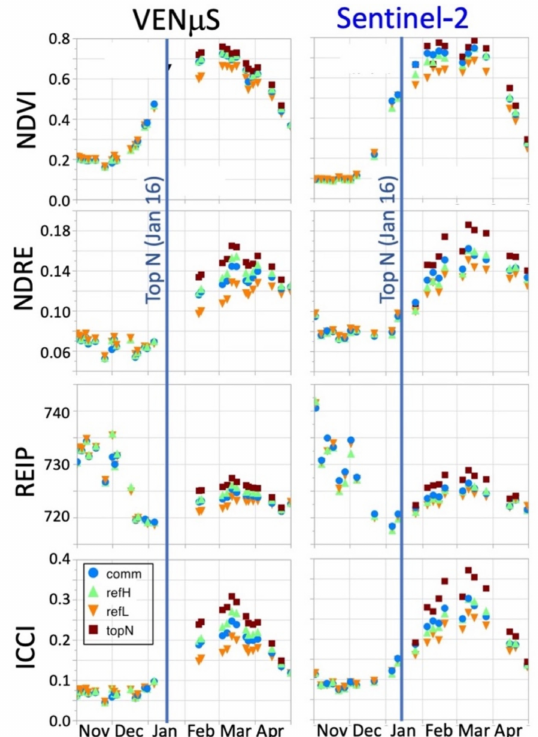
Figure 9. VEN µ S and Sentinel-2 based NDVI, NDRE, REIP, and ICCI along the growing season November 2019–April 2020 in Beit Guvrin (Field 109, Figure 10). Average VI values are plotted for commercial (comm), reference strips (refH, refL), and topdressed N (topN) managements. VEN µ S operation caused missing period January–February